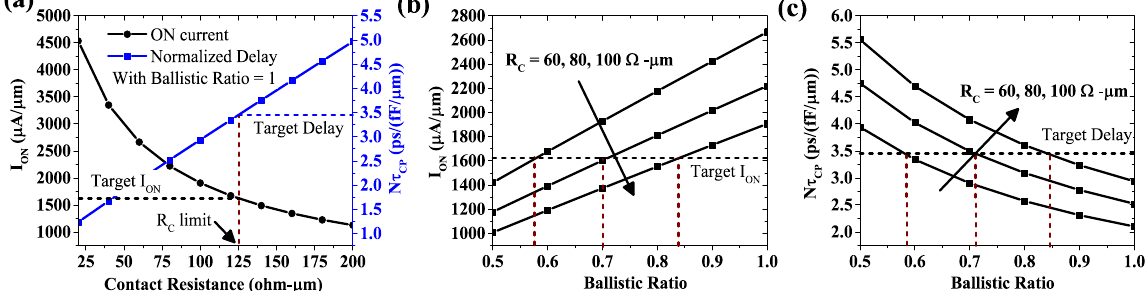
Figure 7. For N3 node with optimized device, ( a ) Effect of S/D contact resistance on ballistic ON current and delay, ( b ) Effect of ballistic ratio on ON current, ( c ) Delay, for different contact resistance values.